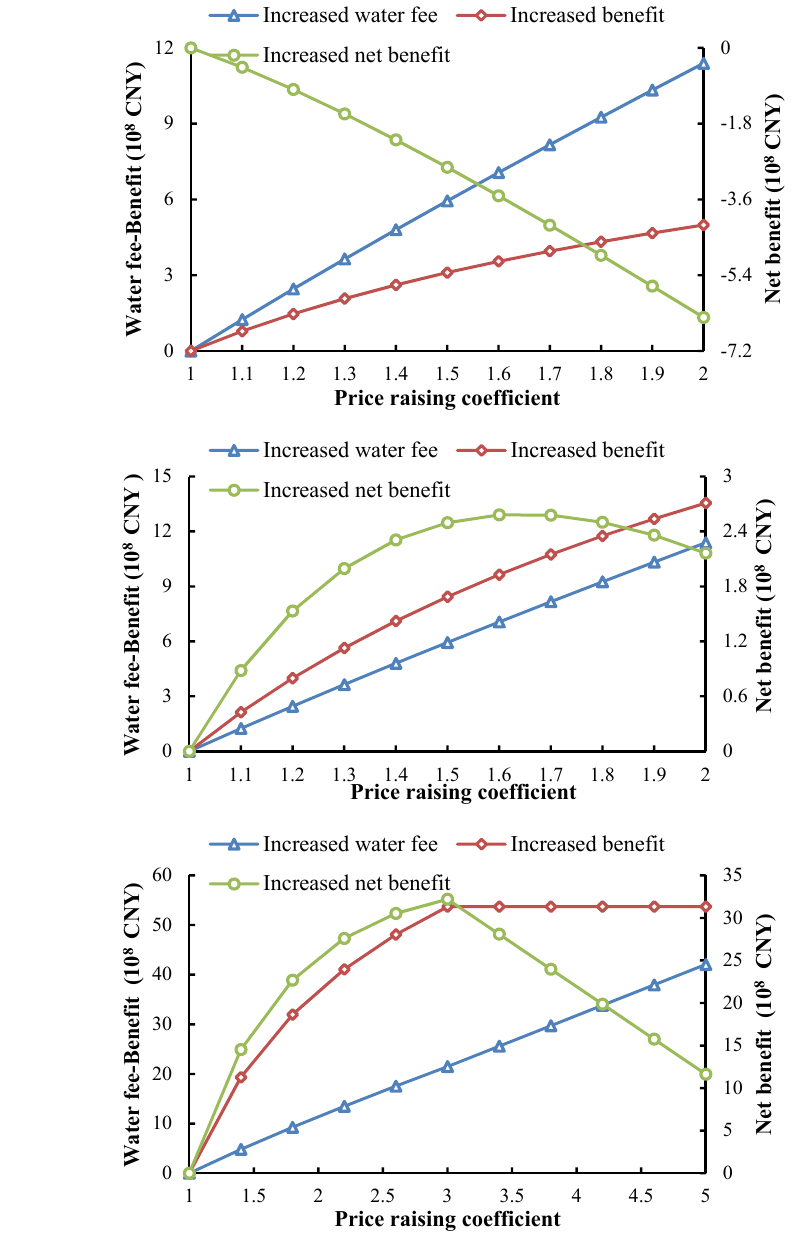
Figure 7. The curves of increased benefit, water fee and net benefit with the change of price raising coefficient: ( a ) industrial water shortage: 1.6 × 10 8 m 3 ; ( b ) industrial water shortage: 2.6 × 10 8 m 3 ; ( c ) industrial water shortage: 3.6 × 10 8 m 3 .